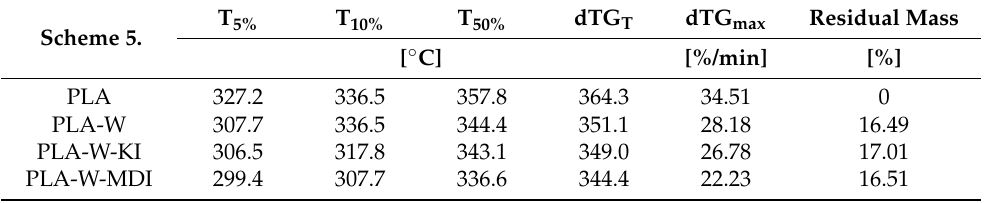
Table 3. Thermal parameters obtained for PLA and PLA-based composites obtained from TGA. Scheme